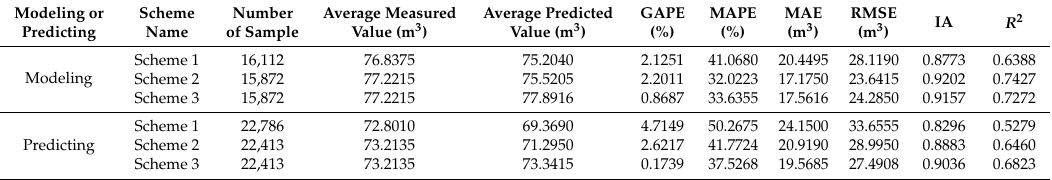
Table 5. The total performance metrics for each scheme for modeling and predicting.